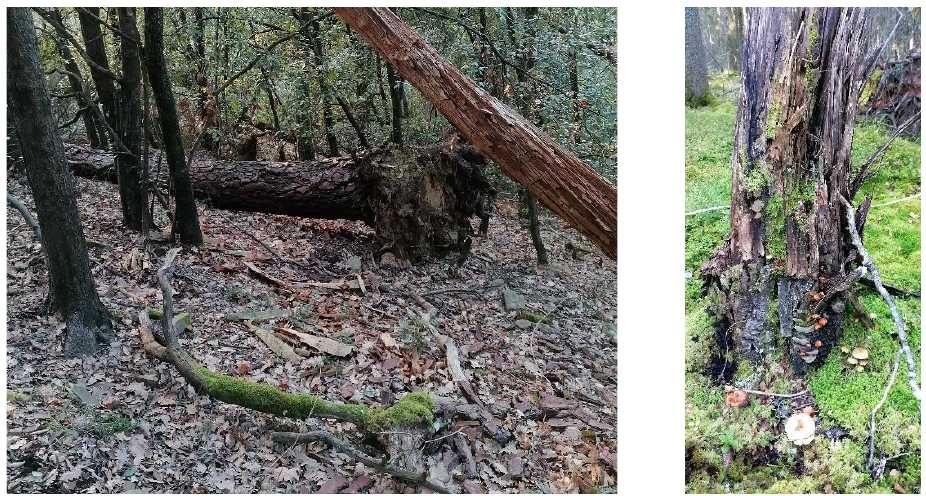
Figure 1. Deadwood: standing and lying trunks, fallen branches, and coarse wood debris.